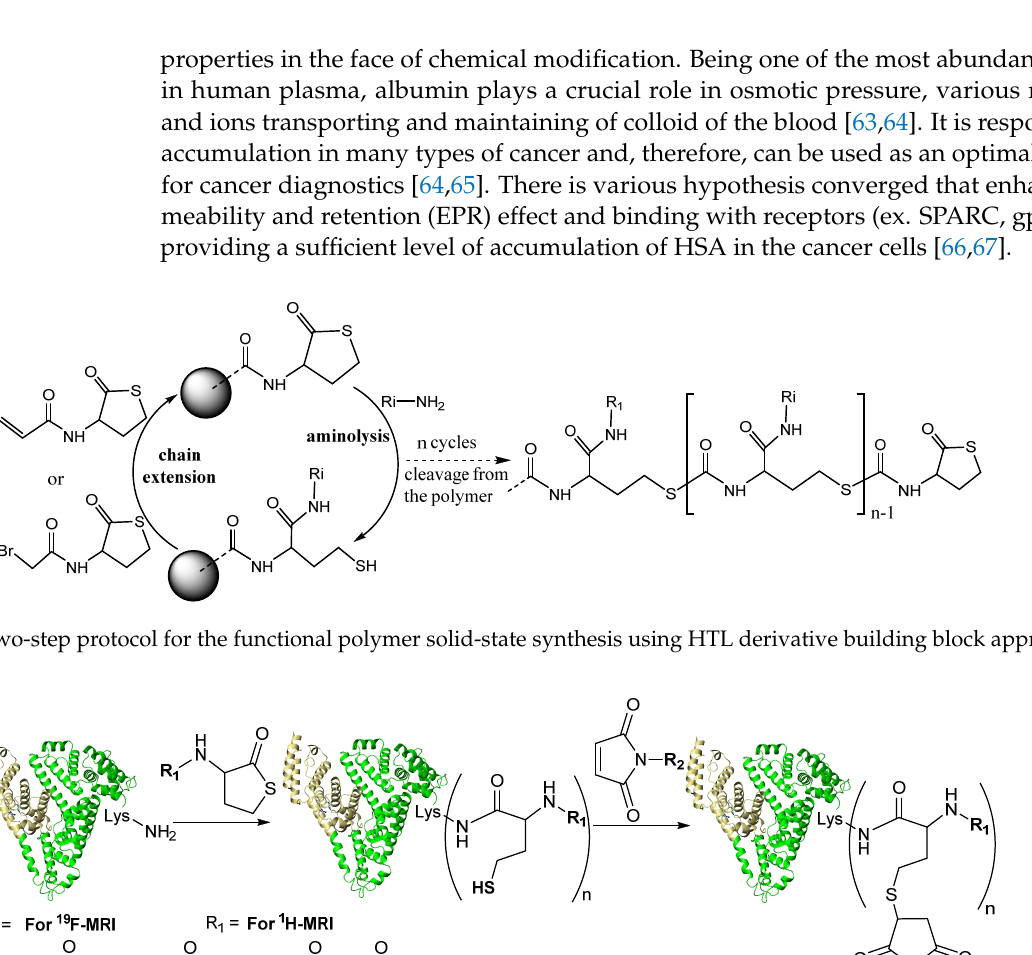
Figure 8. Synthetic routes to obtain the theranostic constructs based on HSA. Drug carrier (shown schematically as a heart-like structure)—HSA. R 1 and R 2 —residues containing MRI probe and anticancer drug, respectively.